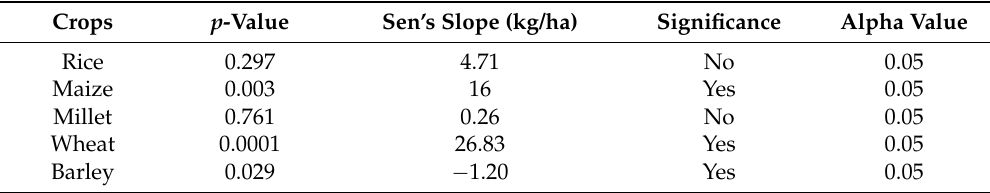
Figure 6. Crop yield trends for rice, maize, millet, wheat and barley from 1980 to 2012. Table 5. Quantification of the crop yield trend with Sen’s slope